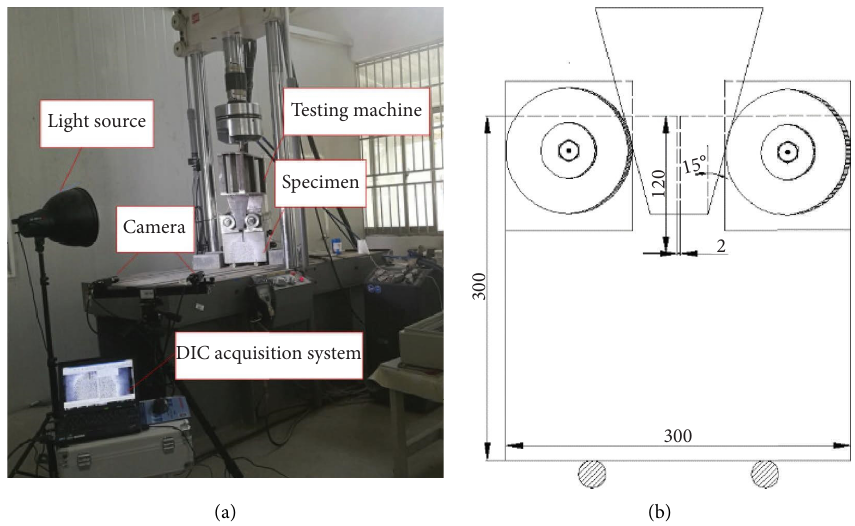
Figure 1: Wedge splitting tensile test device. (a) Physical drawing. (b) Schematic drawing.